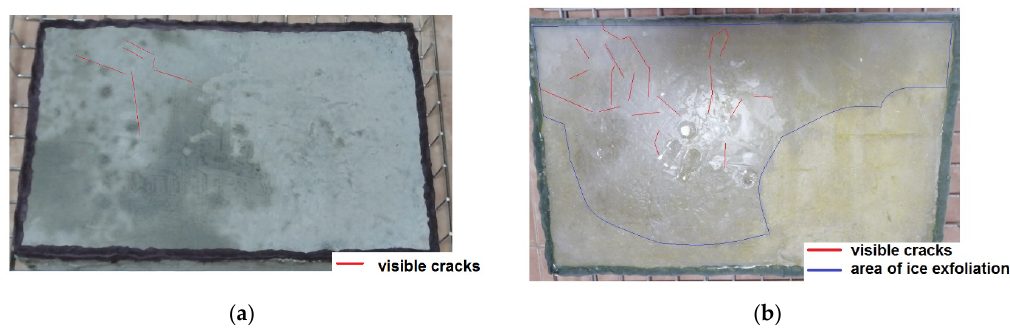
Figure 9. Specimens, after thermal stress simulation: ( a ) Uncoated; ( b ) Coated.